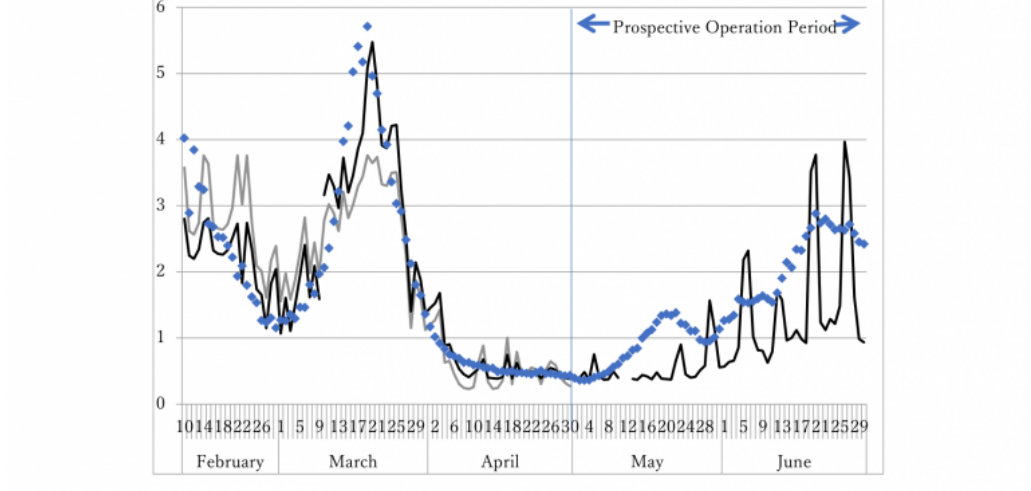
Figure 4. R( t ) and prediction from Apple data. The two black lines represent the prediction from Apple data in the subperiods before and after March 10, 2020; the gray line represents the prediction in the whole period. Dots represent the observed R( t ). Apple data on May 12 and 13 were missing, and the prediction in the period was also missing. Until the end of April 2020, the prediction from Apple data was retrospective; from the beginning of May 2020, the prediction was prospective, although observed R( t ) was calculated as of the date on t +